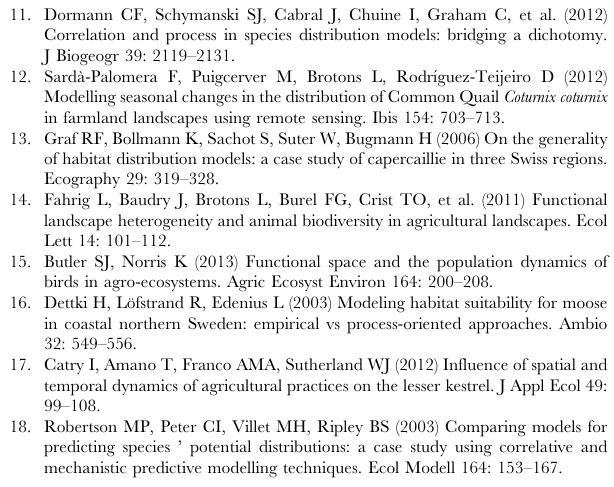
Figure S1 Crop vegetation height in different agricul- tural systems considered in our study throughout the breeding season, according to agricultural practices applied and author’s expert